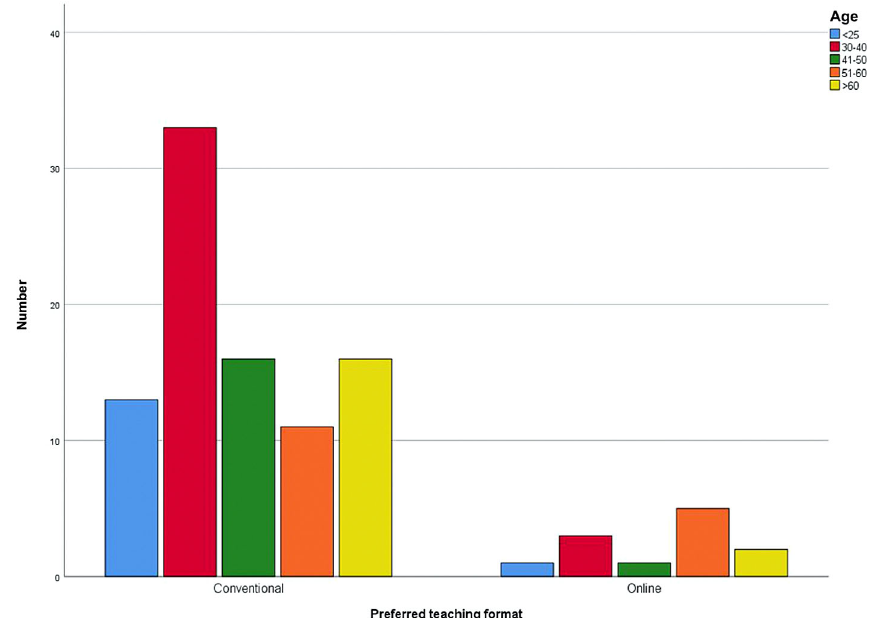
Figure 3. Preferred teaching format for different age groups, separately.